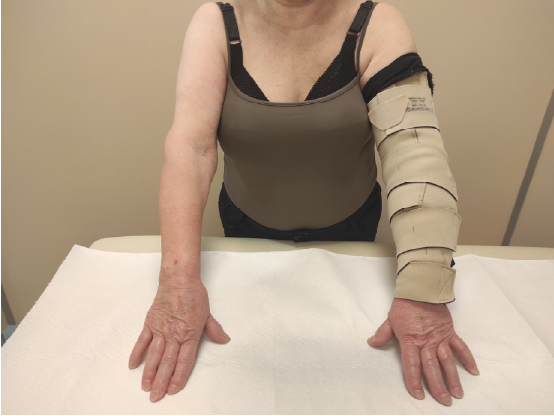
Figure 1. Patient with adjustable compression wrap.